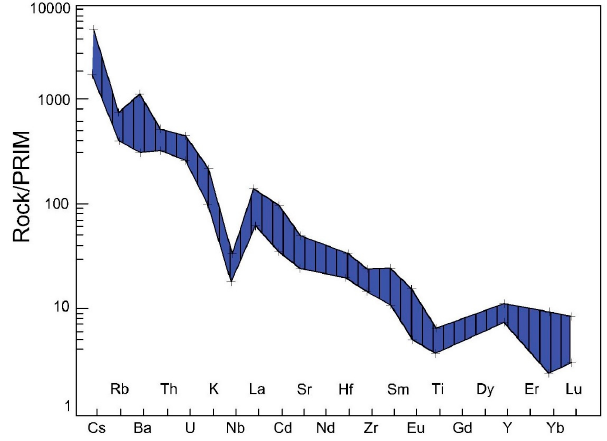
Figure 6. Trace element concentrations normalized to the composition of primitive mantle.